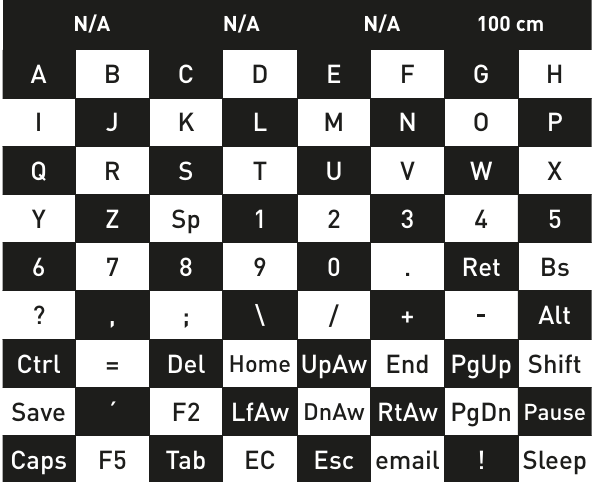
Figure 6. Checkerboard paradigm similar to the one studied in Townsend et al. [102]. Figure modified from